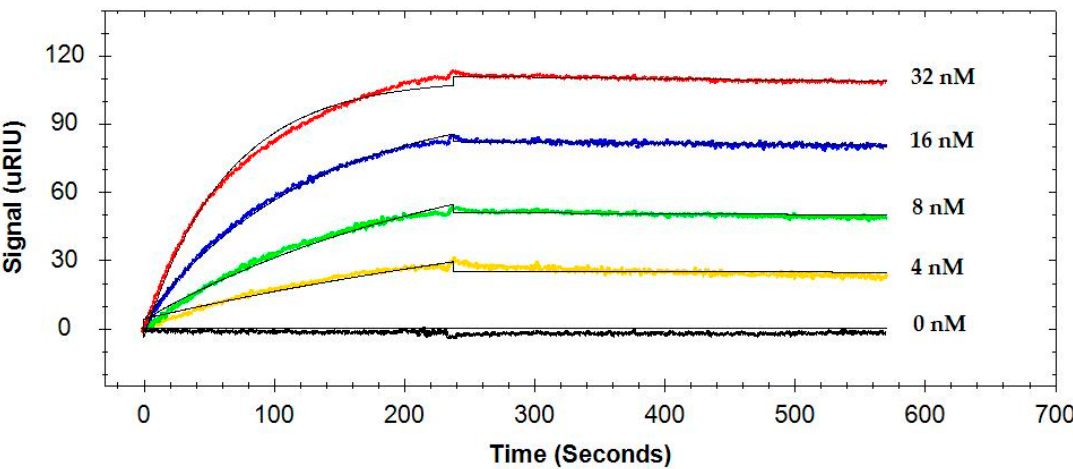
Figure 2. A representative sensorgram showing the interactions of four concentrations of the same antibody (MAb 7E3) to the flagellin captured on the sensor surface by immobilized MAb 1E10. Table 1. Kinetic parameters of four monoclonal antibodies to S. Typhimurium flagellin. Antibodies